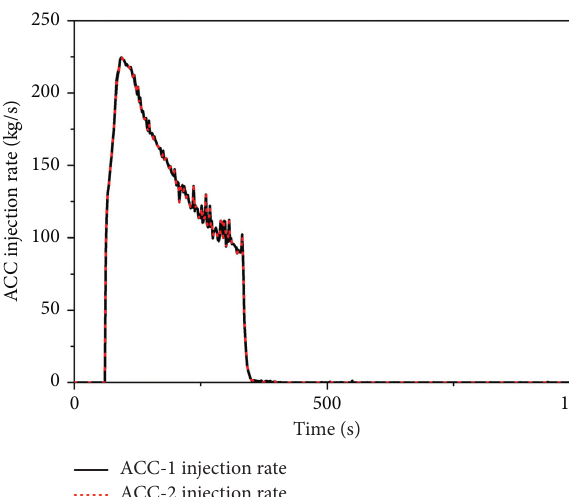
Figure 10: 10-inch CL break ACC discharge mass rate.